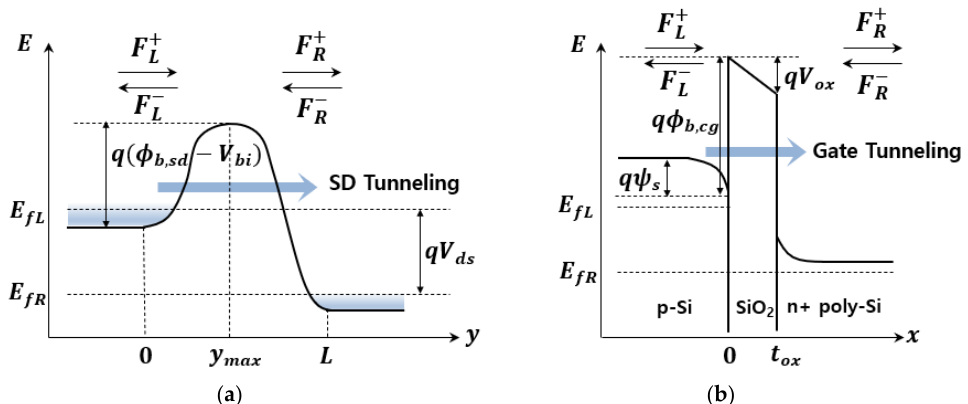
Figure 1. Representation of energy barrier profile ( a ) along the y ‐ axis in the source ‐ drain direction and ( b ) along the x ‐ axis in the channel ‐ gate direction.